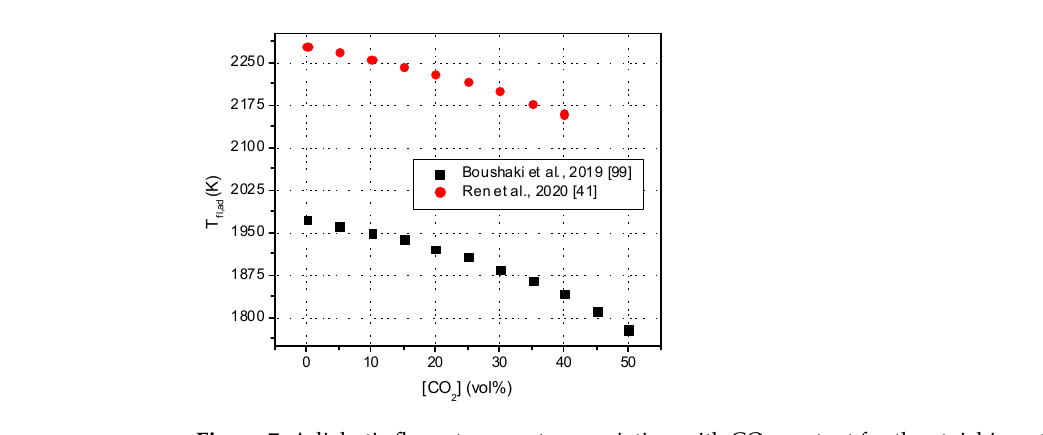
Figure 7. Adiabatic flame temperature variation with CO 2 content for the stoichiometric biogas-air mixture, at 298 K and 1 bar.